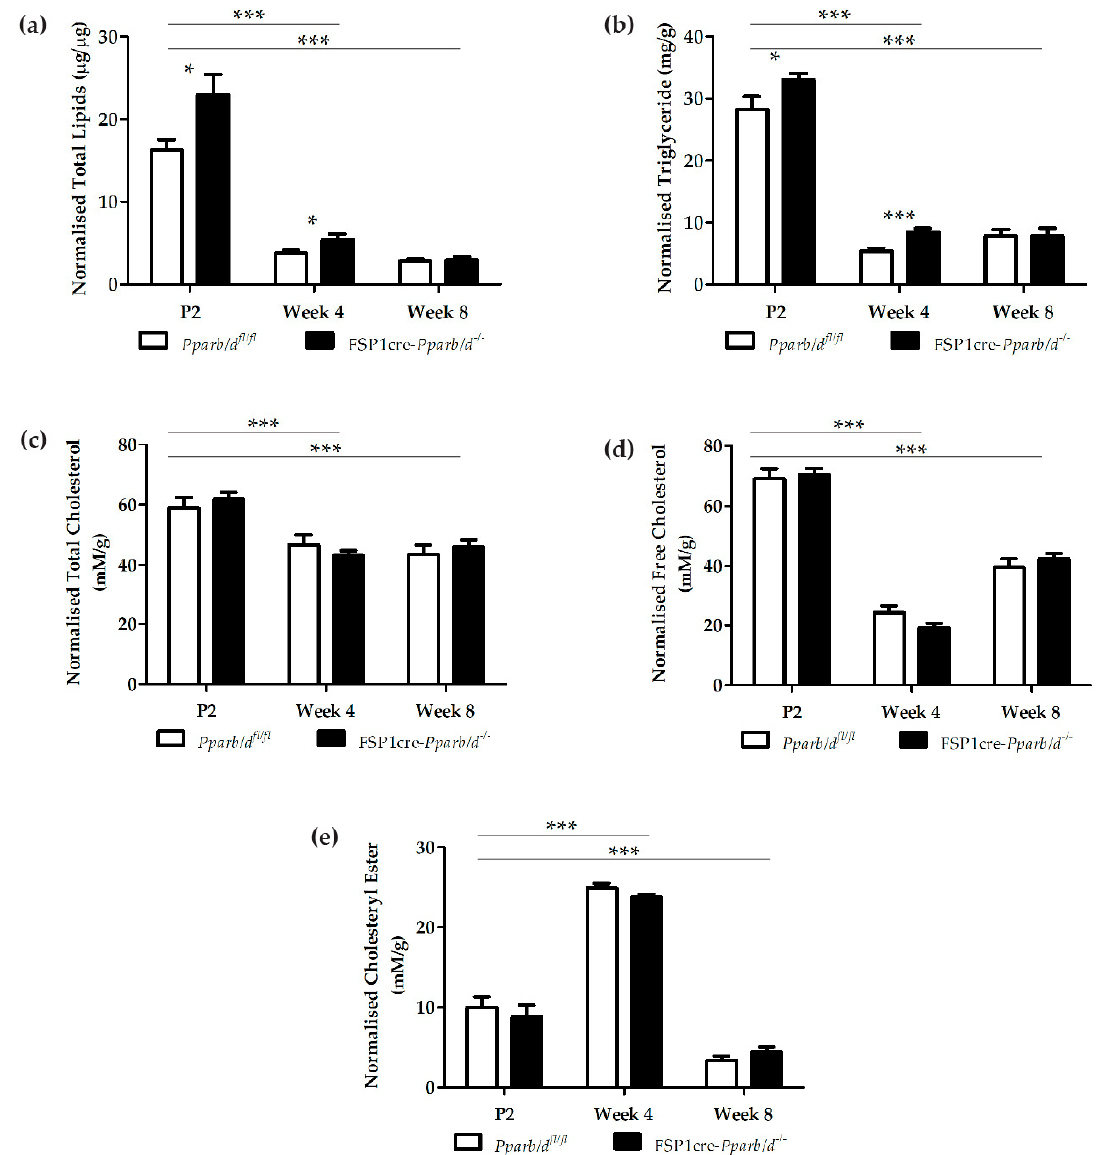
Figure 5. Lipid profiling of Pparb/d fl/fl and FSP1cre- Pparb/d − / − livers at the three age points. ( a ) Normalized total lipids. ( b ) Normalized triglycerides. ( c ) Normalized total cholesterol. ( d ) Normalized free cholesterol. ( e ) Normalized cholesteryl ester. Two-tailed Mann-Whitney test was used to compare differences between Pparb/d fl/fl and FSP1cre- Pparb/d − / − livers of the same age. Two- way ANOVA was used to compare the differences between the ages of Pparb/d fl/fl and FSP1cre- Pparb/d − / − livers. Data are shown as mean ± s.e.m, n = 9 to 10 biological replicates per group. * P < 0.05, *** P <